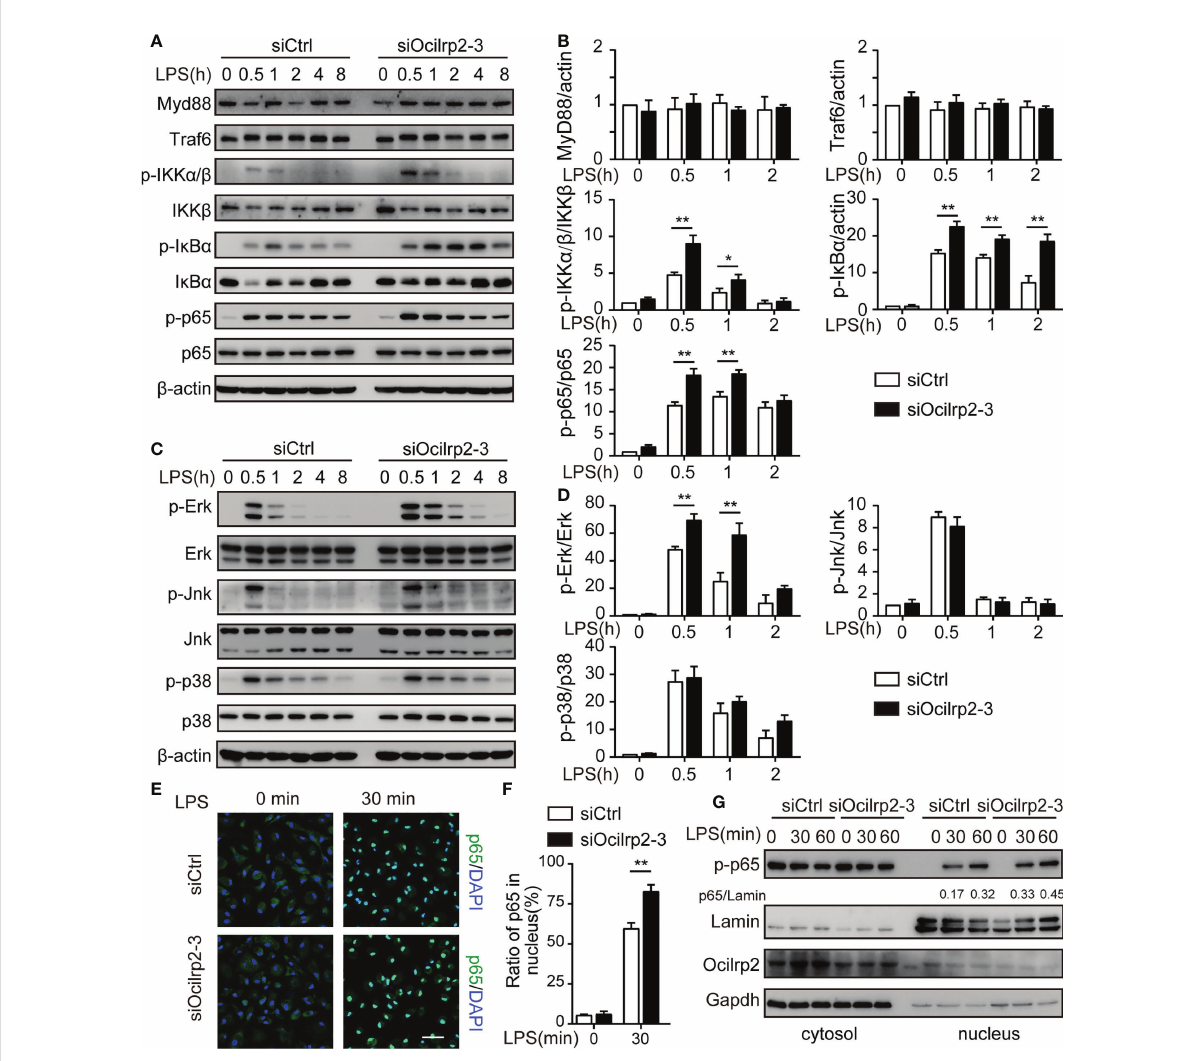
FIGURE 4 Silencing of Ocilrp2 accelerates the activation of the TLR4 signaling. Mouse peritoneal macrophages were treated with or without LPS (1 µg/ml) for different periods, as indicated, after transfection with siCtrl or siOcilrp2-3. (A) Then subjected to Western blot analyses using anti-Myd88, anti-Traf6, and anti- phosphorylated (p-) or total proteins of IKK a / b , I k B a , and p65. (B) Densitometric quanti fi cation of the ratio of Myd88, Traf6, p-IKK a / b , p-I k B a and p-p65. Data were analyzed by three independent experiments. (C) Immunoblot analysis of phosphorylated (p-) or total proteins of pErk, Jnk, and p38 for the indicated time. The b -actin was detected as a loading control. (D) Densitometric quanti fi cation of the ratio of p-Erk, p-Jnk and p-p38. Data were analyzed by three independent experiments. (E) Mouse peritoneal macrophages were transfected with Ocilrp2 siRNA and 48hr later stimulated with LPS for the indicated times. Immuno fl uorescence analysis of the nuclear translocation of p65 and the co-localization between p65 (green) and cell nucleus (blue) (Bar, 50 m m). (F) Quantifying of p65 protein translocation based on the visual images in c, ~300 cells for each time point. (G) Immunoblot analysis of p65 protein in cytoplasm and nucleus of mouse peritoneal macrophages transfected with Ocilrp2 siRNA and 48 h later stimulated by LPS for the indicated time. Lamin A/C is used as an internal nuclear control. GAPDH is shown as a cytoplasm internal control. Data represent of the results of three independent experiments (means ± s.e.m). Signi fi cant differences compared to the control group are denoted by * P < 0.05, ** P < 0.01 (two-tailed Student ’ s